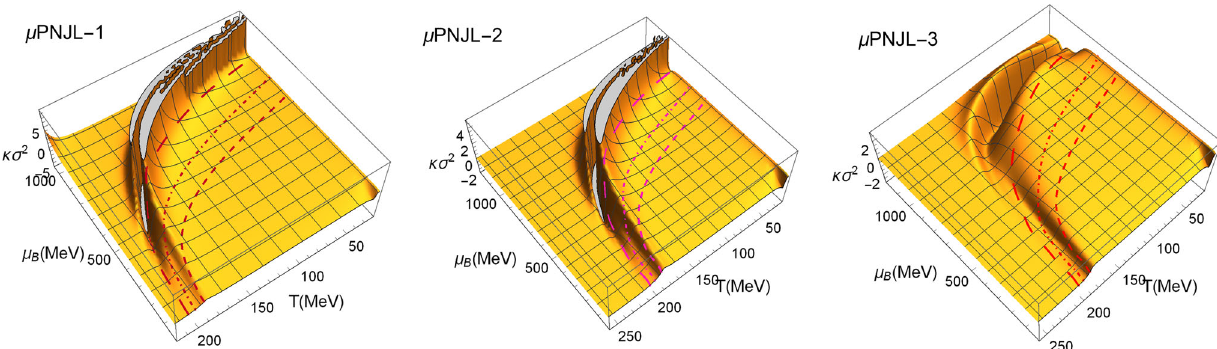
Fig. 6 The 3D plot for the kurtosis of baryon number fluctuation κσ 2 as a function of the temperature and baryon chemical potential in the μ PNJLmodel.Thelongdashed,dashed-dottedanddashedlinesineach